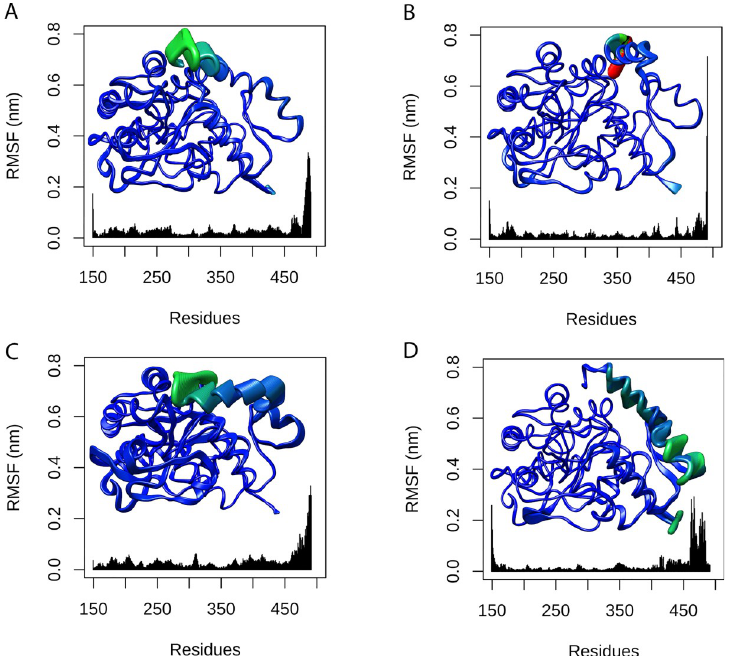
Fig 8. RMSF contribution to PC1 of WT TPH2 and its variants. The RMSF contribution of each protein residue to PC1 is shown as a line plot and projected on the corresponding structure. Each residue of TPH2 WT and variants was colored and sized according to its RMSF contribution. The coloring-thickness scale varies from dark blue and thin (low fluctuations) to red and thick (high fluctuations). (A) RMSF contribution of WT TPH2 to PC1. (B) RMSF contribution of variant P206S to PC1. (C) RMSF contribution of variant R303W to PC1. (D) RMSF contribution of variant R441H to